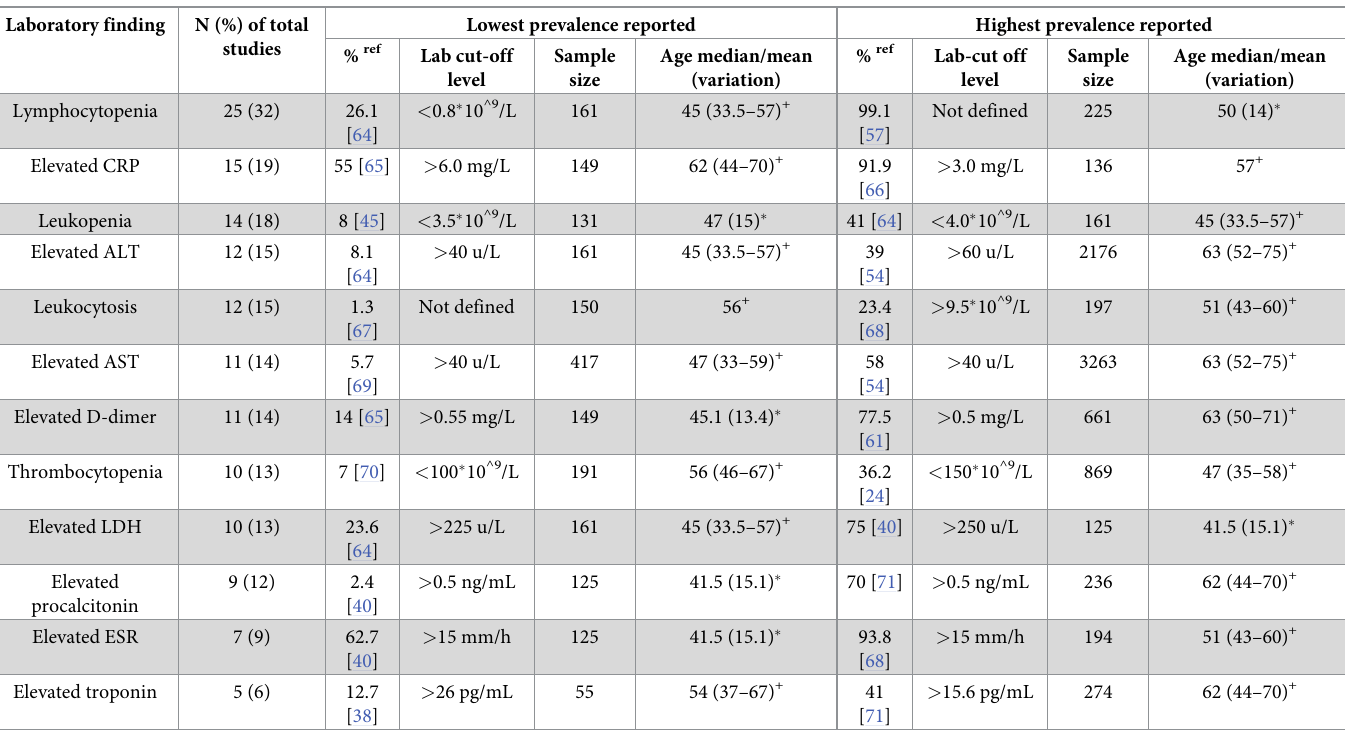
Table 3. Abnormal laboratory findings in Covid-19.